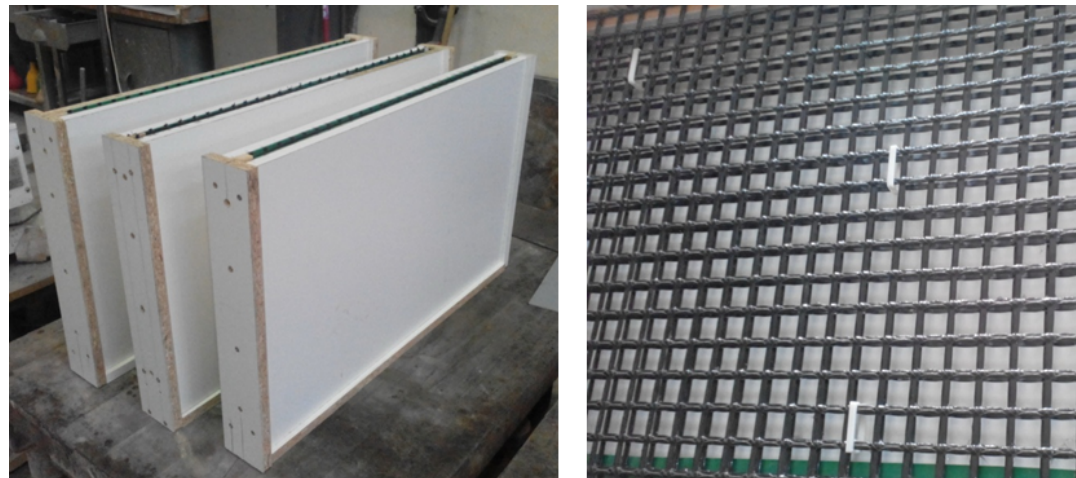
Figure 3. Formwork for TRLC slabs with 2D carbon textile.